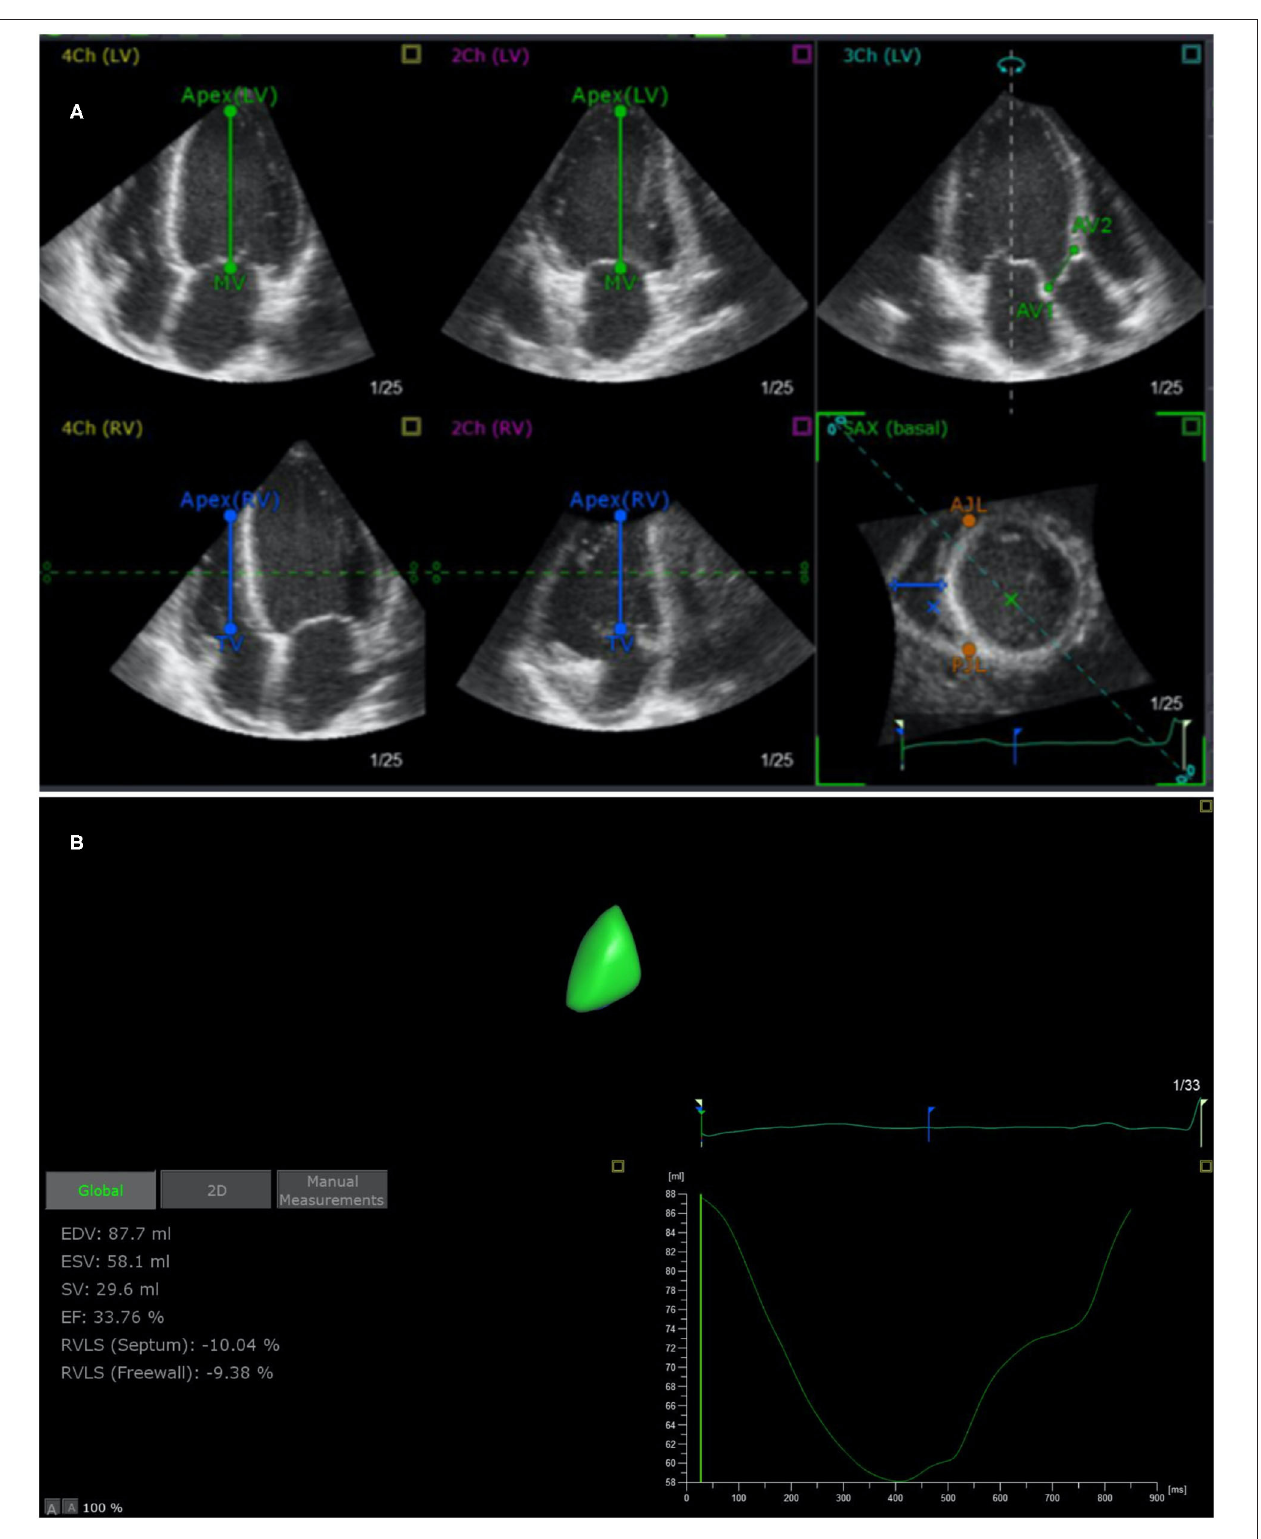
FIGURE 1 | End-systolic verification and editing of endocardial RV borders using TomTec 4D RV Function 2.0 (A) and 4D auto-RVQ measurement (B) . RV, right ventricular; EDV, end-diastolic volume; ESV, end-systolic volume; EF, ejection fraction; RVLS (septum), right ventricular longitudinal strain of the septum; RVLS (free wall), right ventricular longitudinal strain of the free wall; TAPSE, tricuspid annular plane systolic excursion.